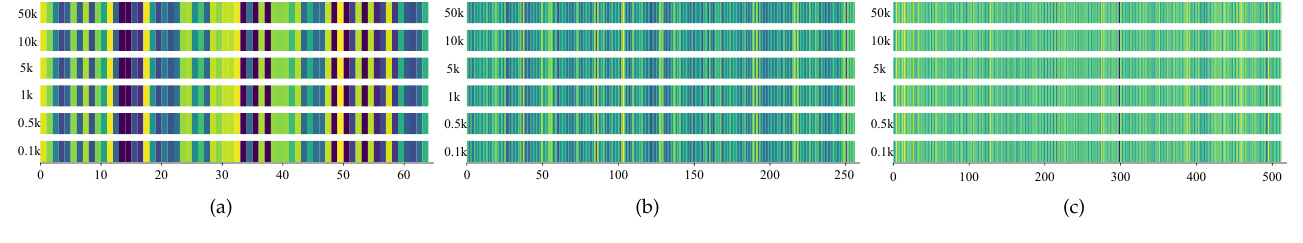
Figure 4. The expectation of centroid deviations of the feature maps with different sampled